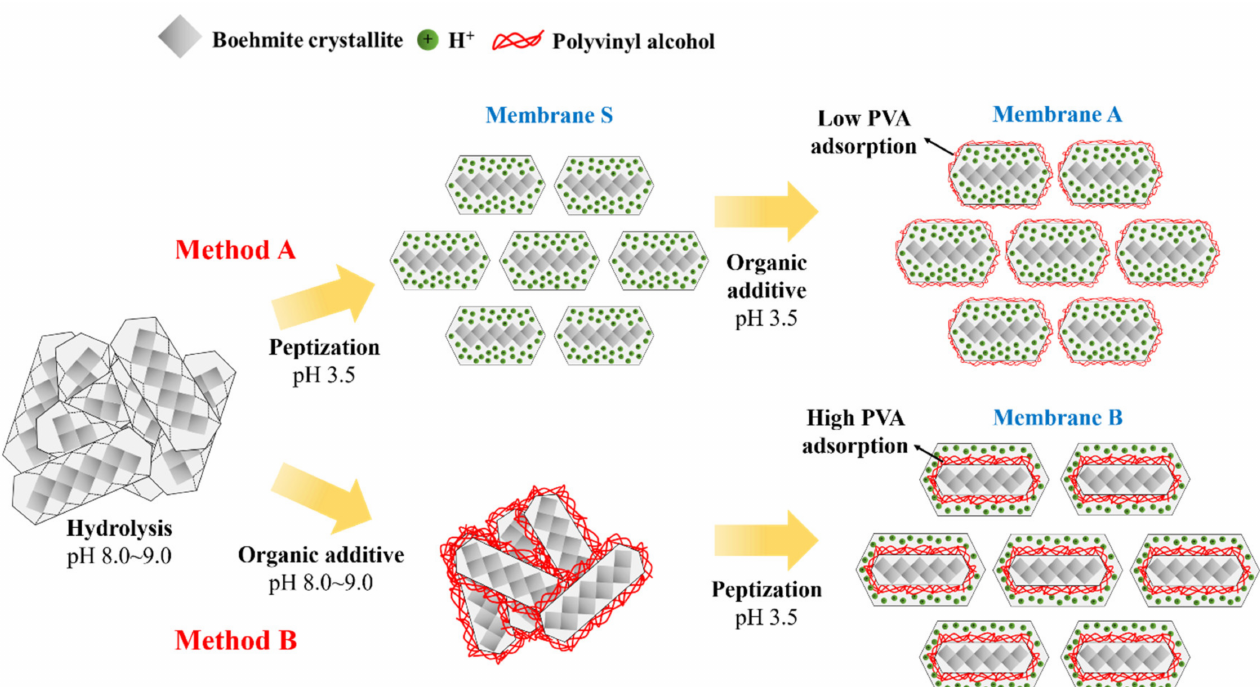
Figure 5. Schematic diagram of the proposed mechanism for the formation of γ -Al 2 O 3 tight ultrafil- tration (UF) membranes using methods A and